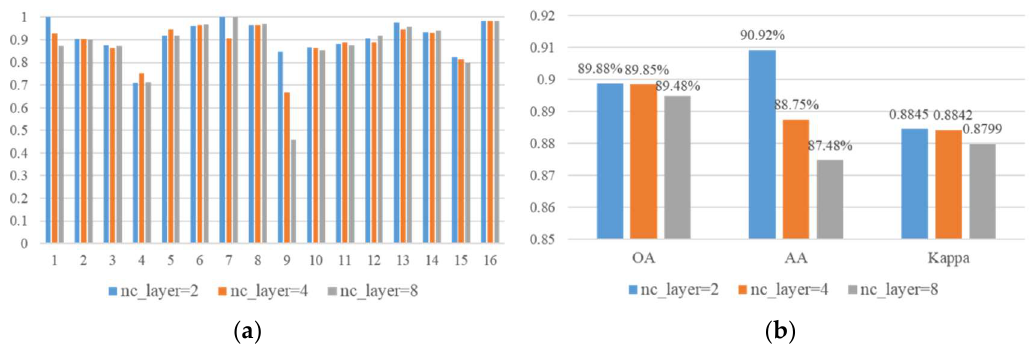
Figure 13. Classification results of proposed method nc_layer = 2, g = 8/20/32: ( a ) shows the classification accuracy per class, ( b ) shows the OA/AA/Kappa.